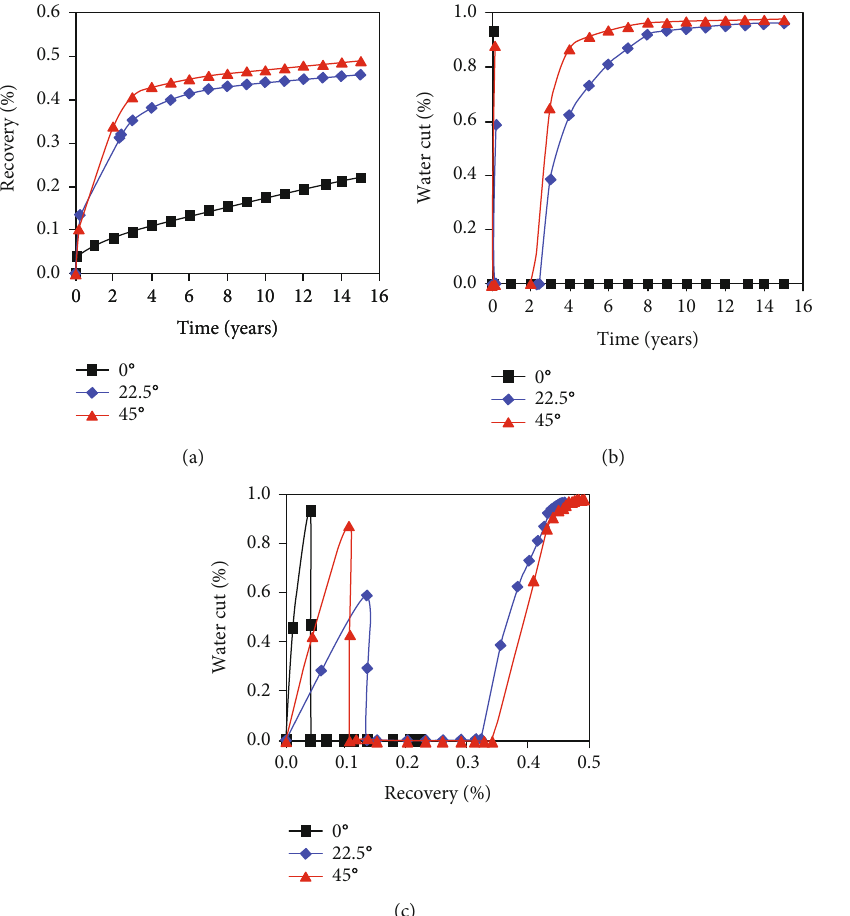
Figure 3: The production curves of the di ff erent angle models. (a) Recovery versus time, (b) water cut versus time, and (c) water cut versus